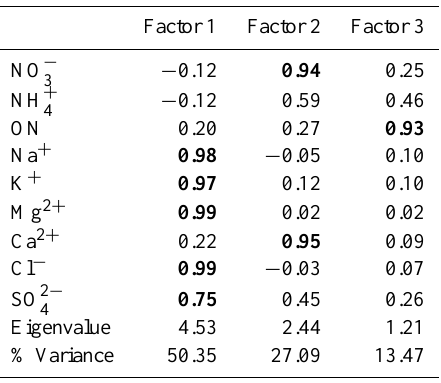
Figure 4. Volume-weighted average concentrations of reactive ni- trogen species for precipitation events associated with the three types of air masses at Uljin. Error bars represent standard devia- tions. Table 2. Varimax-rotated principal factor matrix ∗ . Factor loadings exceeding 0.7 are shown in